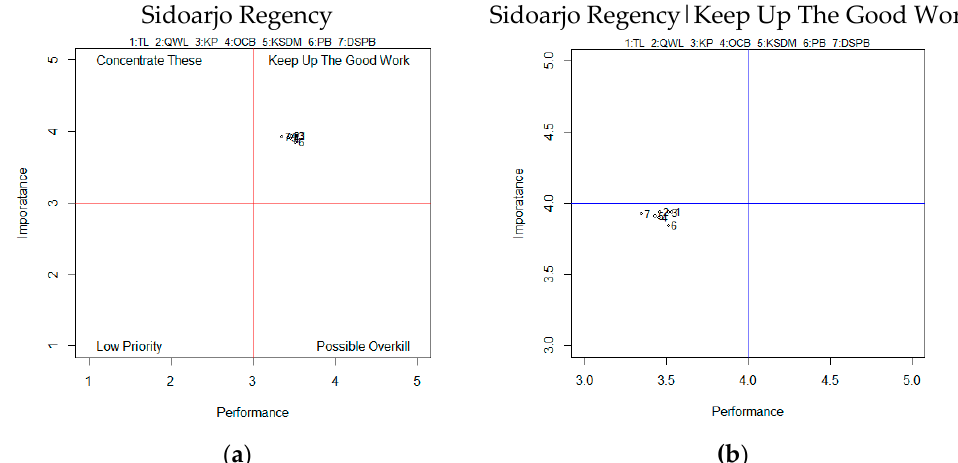
Figure 6. ( a ) IPA Cartesian Diagram of Sidoarjo Regency. ( b ) IPA Cartesian Diagram of Keep up the Good Work Quadrant of Sidoarjo Regency.